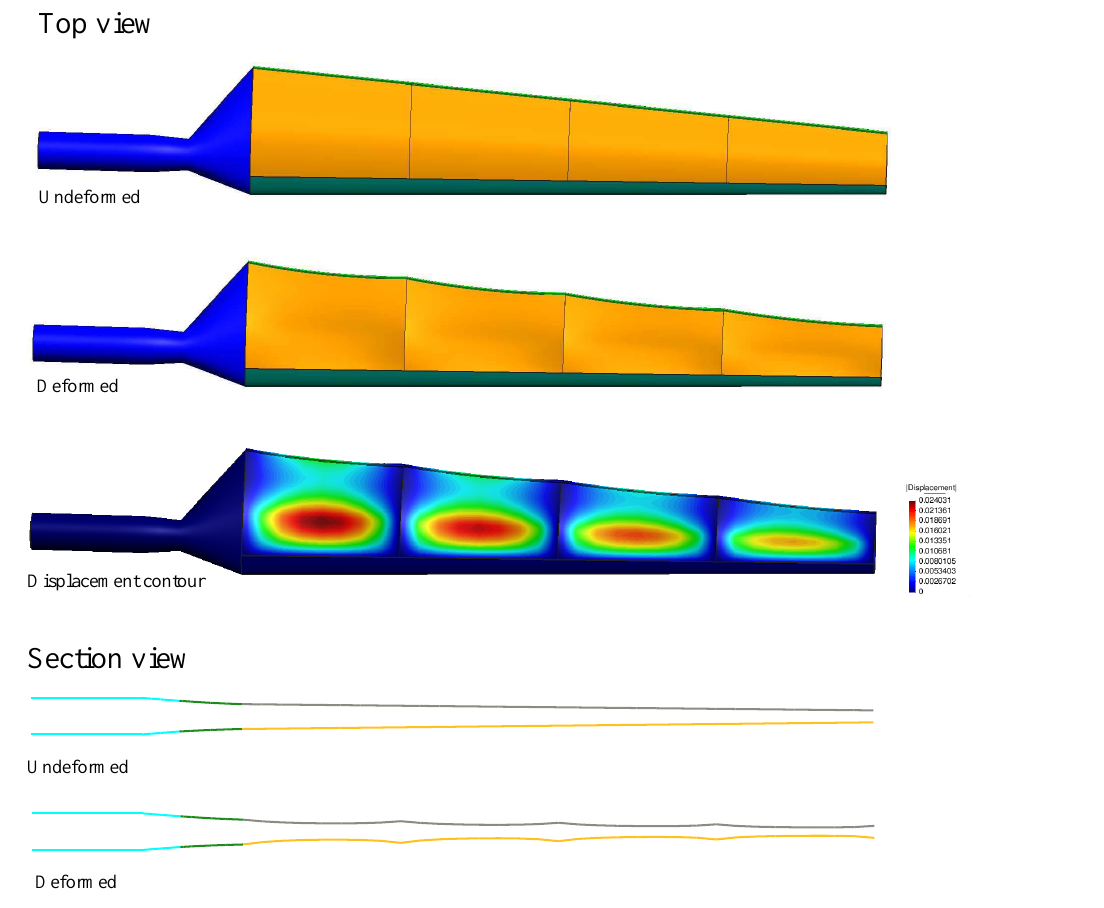
Figure 10. Form finding of the membrane blade. Undeformed and deformed geometry from top and front views.